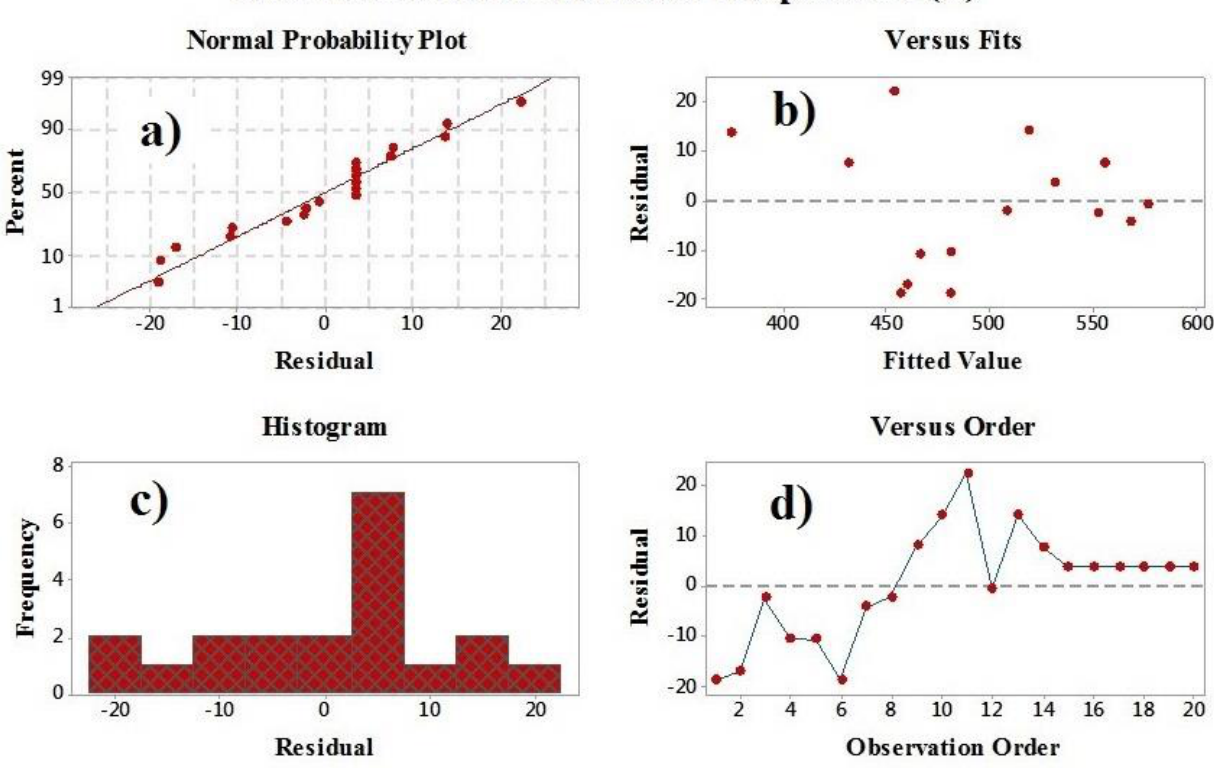
Figure 6. Evaluation results of regression model ( a ) normal probability plot, ( b ) versus fits, ( c ) histogram and ( d ) versus order. The final regression equation for the peak temperature was obtained as Equation (2) as a function of dependent